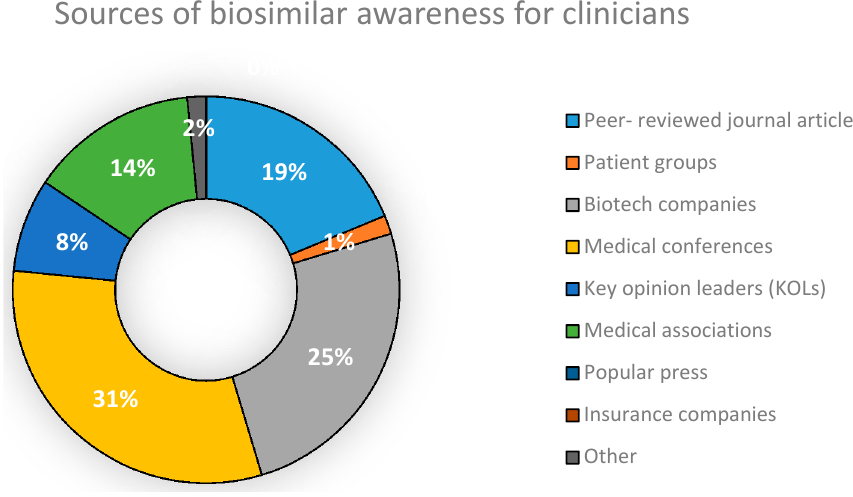
Figure 4. Sources of biosimilar awareness for Clinicians in Bangladesh.